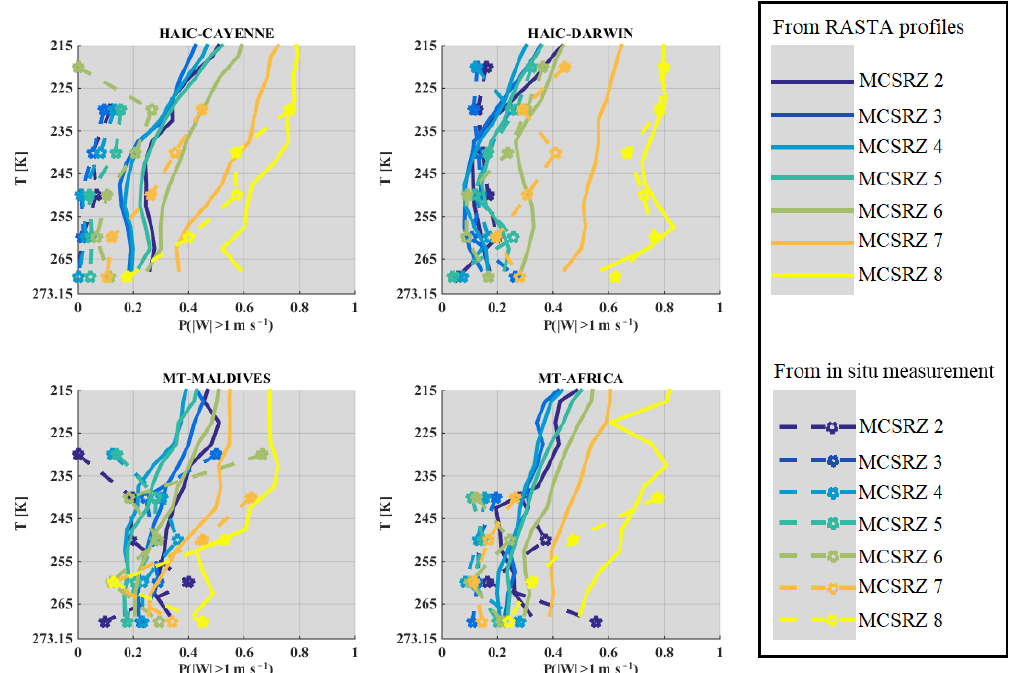
Figure 4. Probability to observe vertical velocity with an absolute magnitude larger than 1ms − 1 in each MCS reflectivity zone (MCSRZ; color scale) for measurements from the radar Doppler RASTA (solid lines) and in situ measurements (dashed lines with